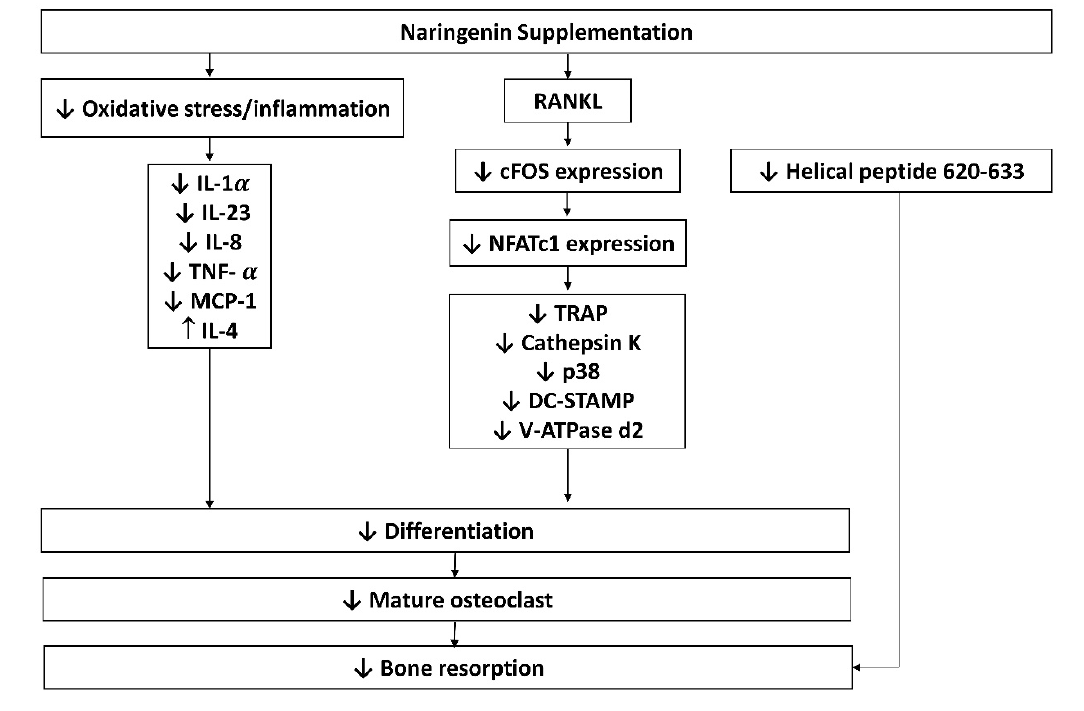
Figure 4. Possible mechanism of actions of naringenin on osteoclasts. Abbreviations: IL-1 α , -23, -8, -4, interleukin-1 alpha, -23, -8, -4; NFATc1, nuclear factor of activated T- cells; OPG, osteoprotegerin; OSX, osterix; RANKL, receptor activator of nuclear factor-kappa B; ligand; TNF- α , tumour necrosis factor-alpha; TRAP, tartrate-resistant acid phosphatase; p38, phosphoinositide 38; DC-STAMP, dendritic cell-specific transmembrane protein; V-ATPase d2, vacuolar-type proton-translocating ATPase; MCP-1, monocyte chemoattractant protein-1.